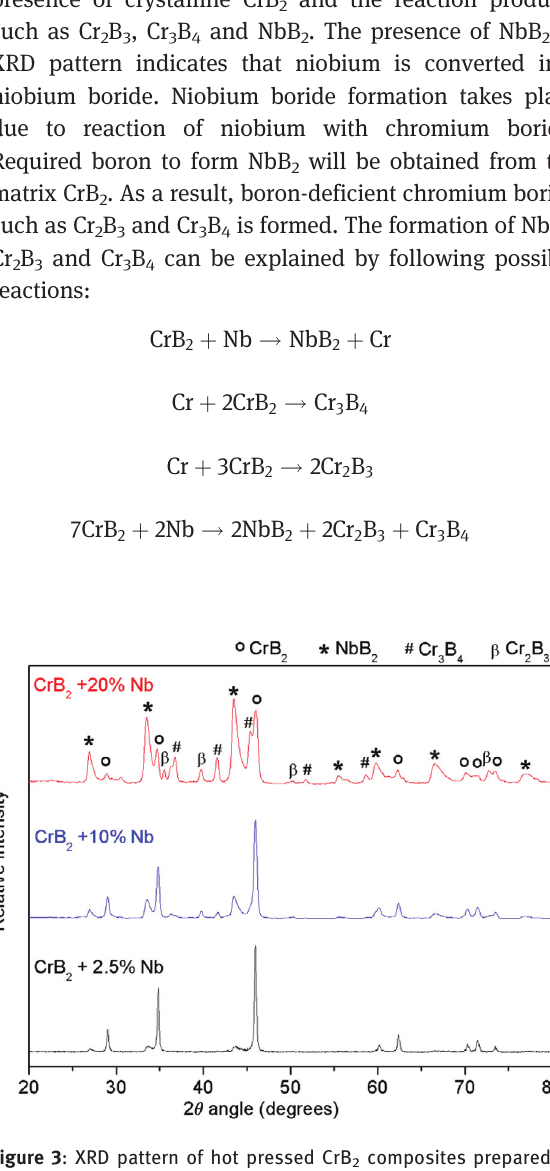
Figure 3 : XRD pattern of hot pressed CrB 2 composites prepared by addition of Nb.